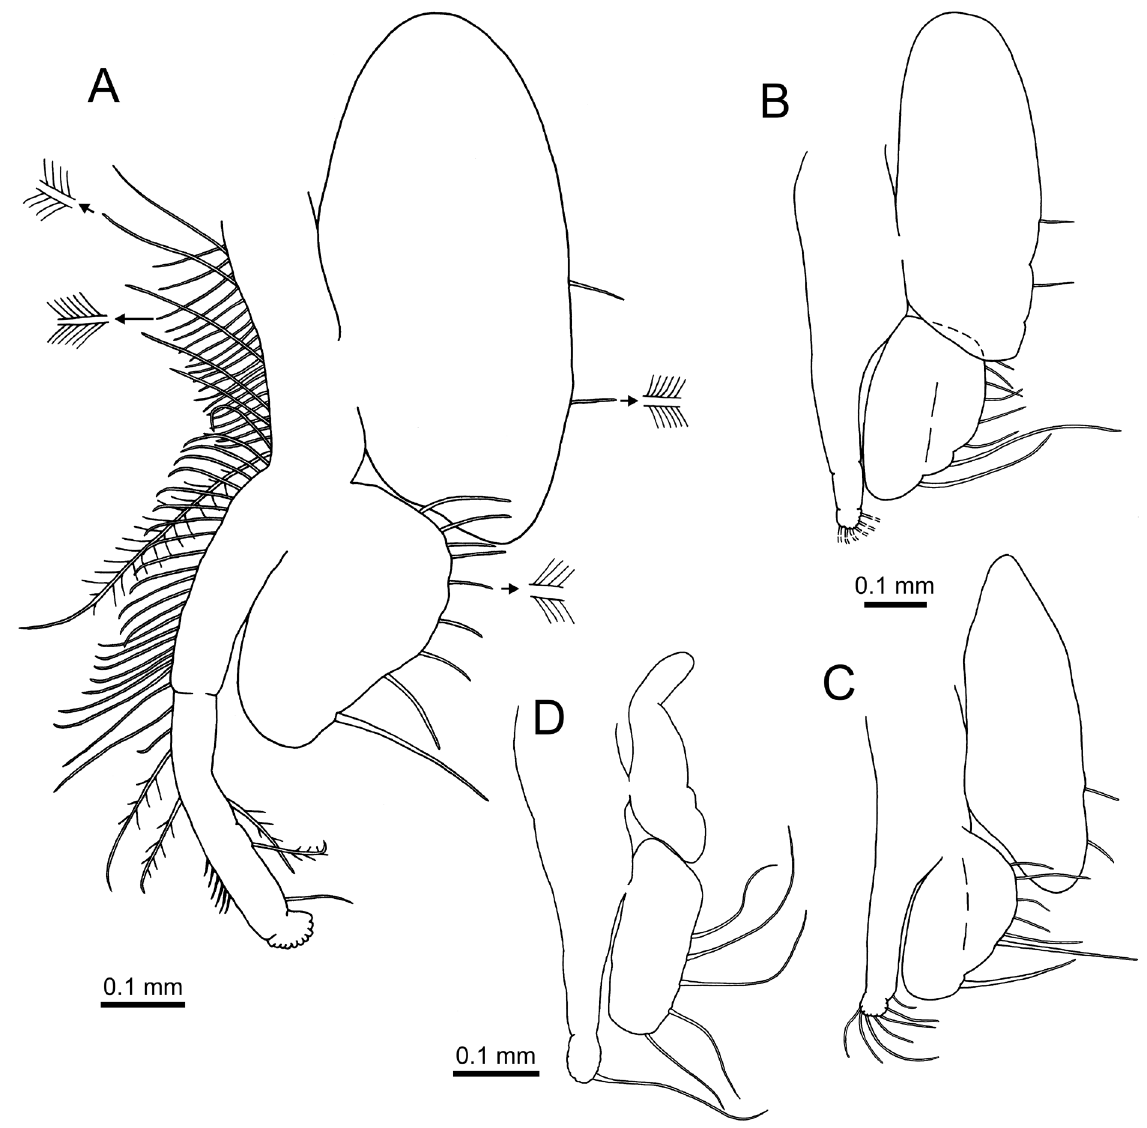
Fig. 13. Sarsinebalia ledoyeri sp. nov. Female, paratypes (MNCN 20.04/13708). A . Thoracopod III, showing setation. B . Thoracopod V. C . Thoracopod VII. D . Thoracopod VIII. A, D: postovigerous female; B–C: preovigerous female, same scale bar; B–D: only selected setae